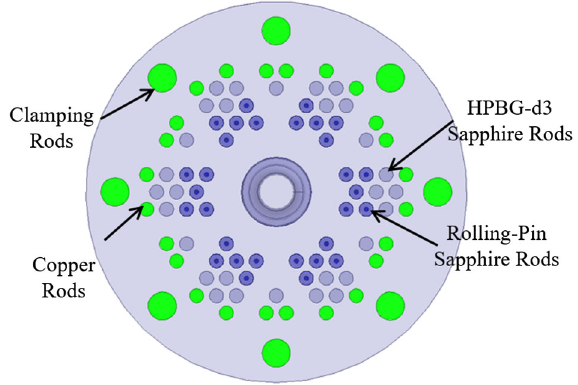
FIG. 12. Top view of the HFSS model of the HPBG-Pin structure.